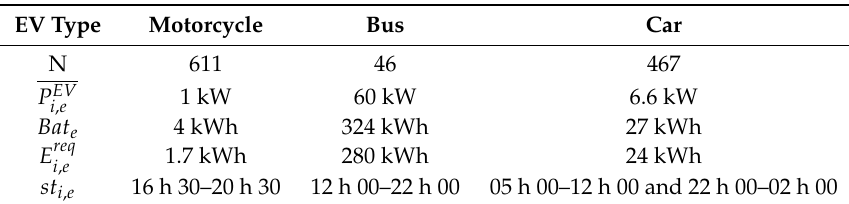
Table 2. EV characteristics